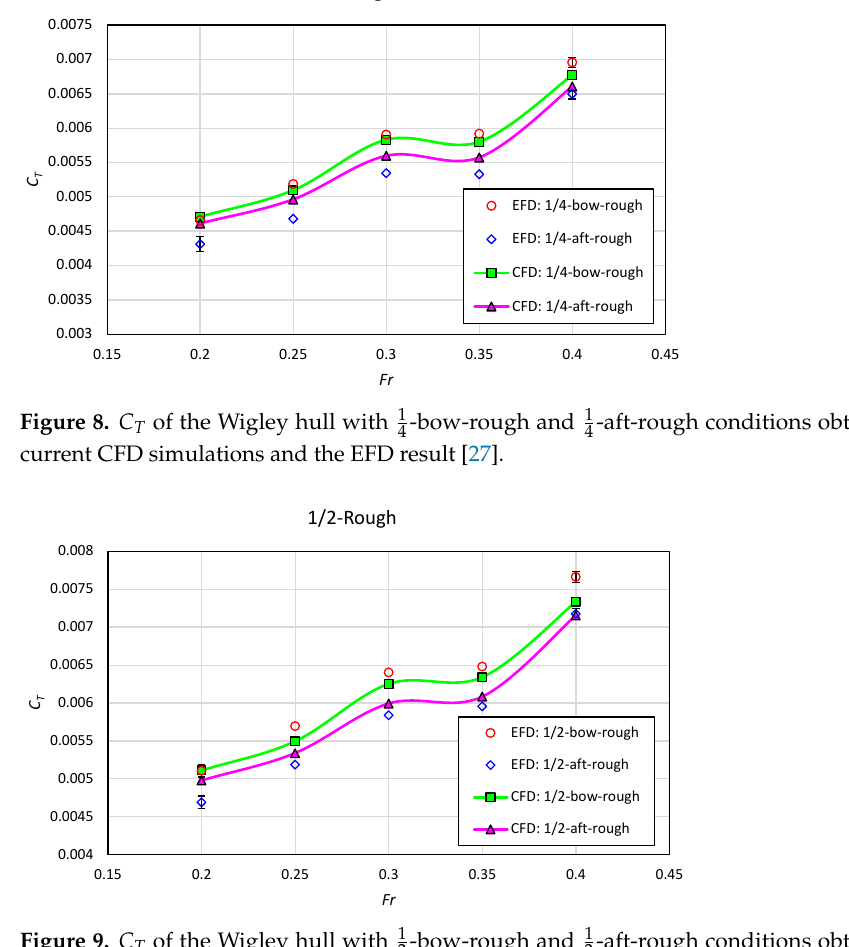
Figure 9. C T of the Wigley hull with 1 -bow-rough and 1 -aft-rough conditions obtained from the 2 2 Figure 9. 𝐶 (cid:3021) of the Wigley hull with ½-bow-rough and ½-aft-rough conditions obtained from the current CFD simulations and the EFD result current CFD simulations and the EFD result [27].